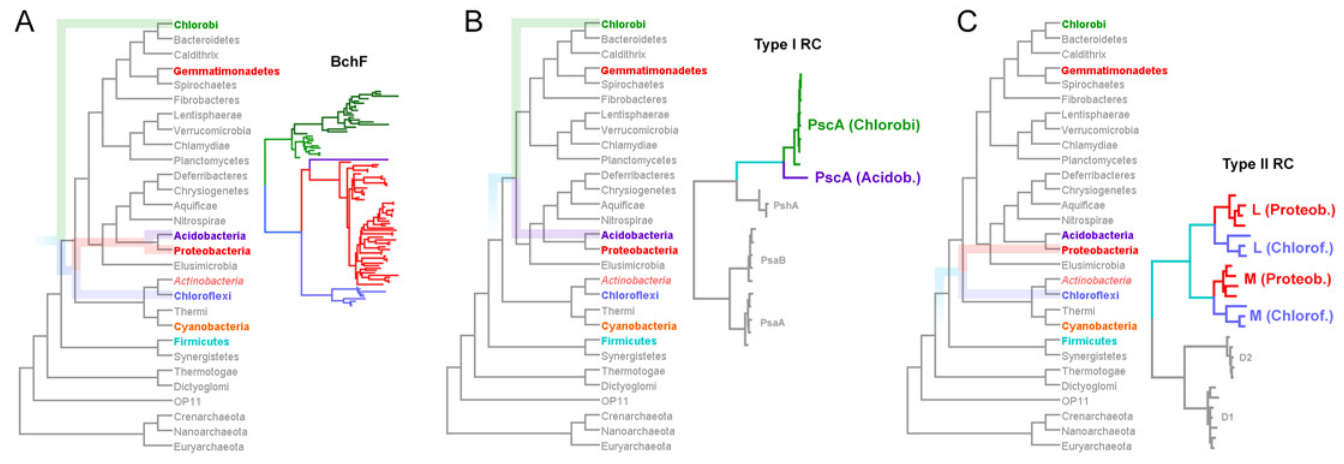
Fig 2. Evolution of bacteria in relation to BchF and reaction center proteins. A shows a phylogenetic tree of BchF overlaid over a phylogenomic tree of prokaryotes. B and C show those of Type I and Type II reaction center proteins over the phylogenomic tree, respectively. The phylogenomic tree that depicts the evolutionary relationship of different phyla of bacteria was obtained from Segata et al. [17], which was published open access. It was constructed using hundreds of proteins and thousands of genomes and the phylogenetic method, sequence alignments, and the phylogenetic tree are freely available from the author ’ s website (http://huttenhower.sph.harvard.edu/phylophlan). It is overall very similar to other phylogenomic trees, and the relationship of phyla containing phototrophic strains is virtually identical to those presented before, see for example Jun et al. [20], who implemented an alignment free approach. The phyla of bacteria highlighted in color represent those with photochemical reaction centers, with the exception of Actinobacteria that only recently was suggested to have been ancestrally phototrophic [2]. The colored transparent lines that are overlaid on top of the phylogenomic tree represent the evolution of the selected proteins. The phylogenetic relations of Type I ( B ) and Type II ( C ) reaction centers are well-established and were recently reviewed in detail [1].